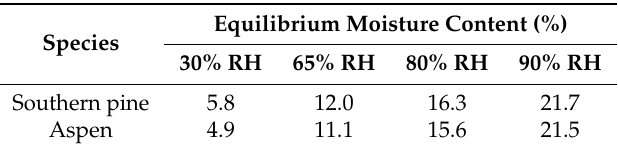
Table 1. Equilibrium Moisture Content of Pine and Aspen [1].